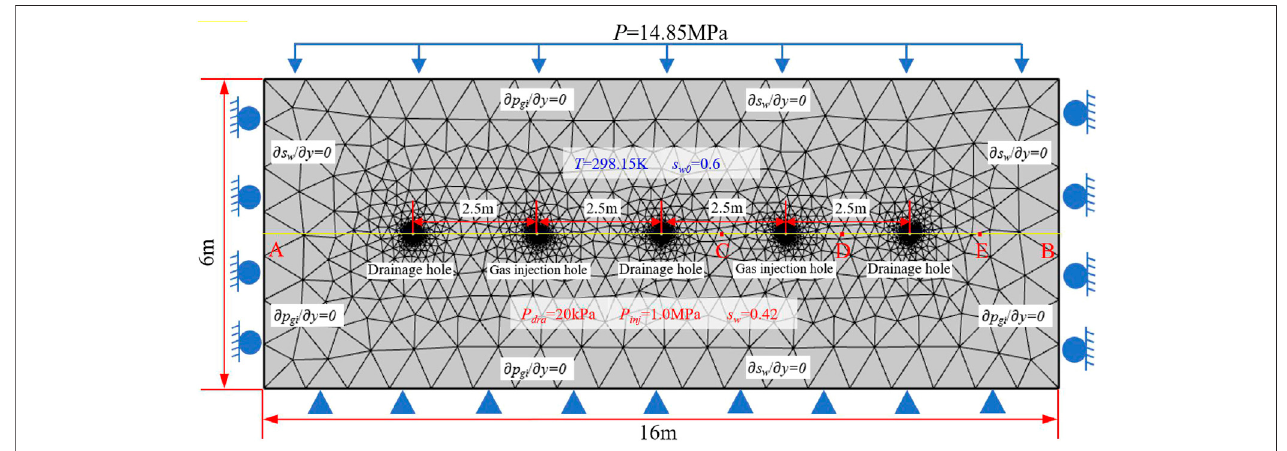
FIGURE 2 | Physical geometry model of numerical simulation.